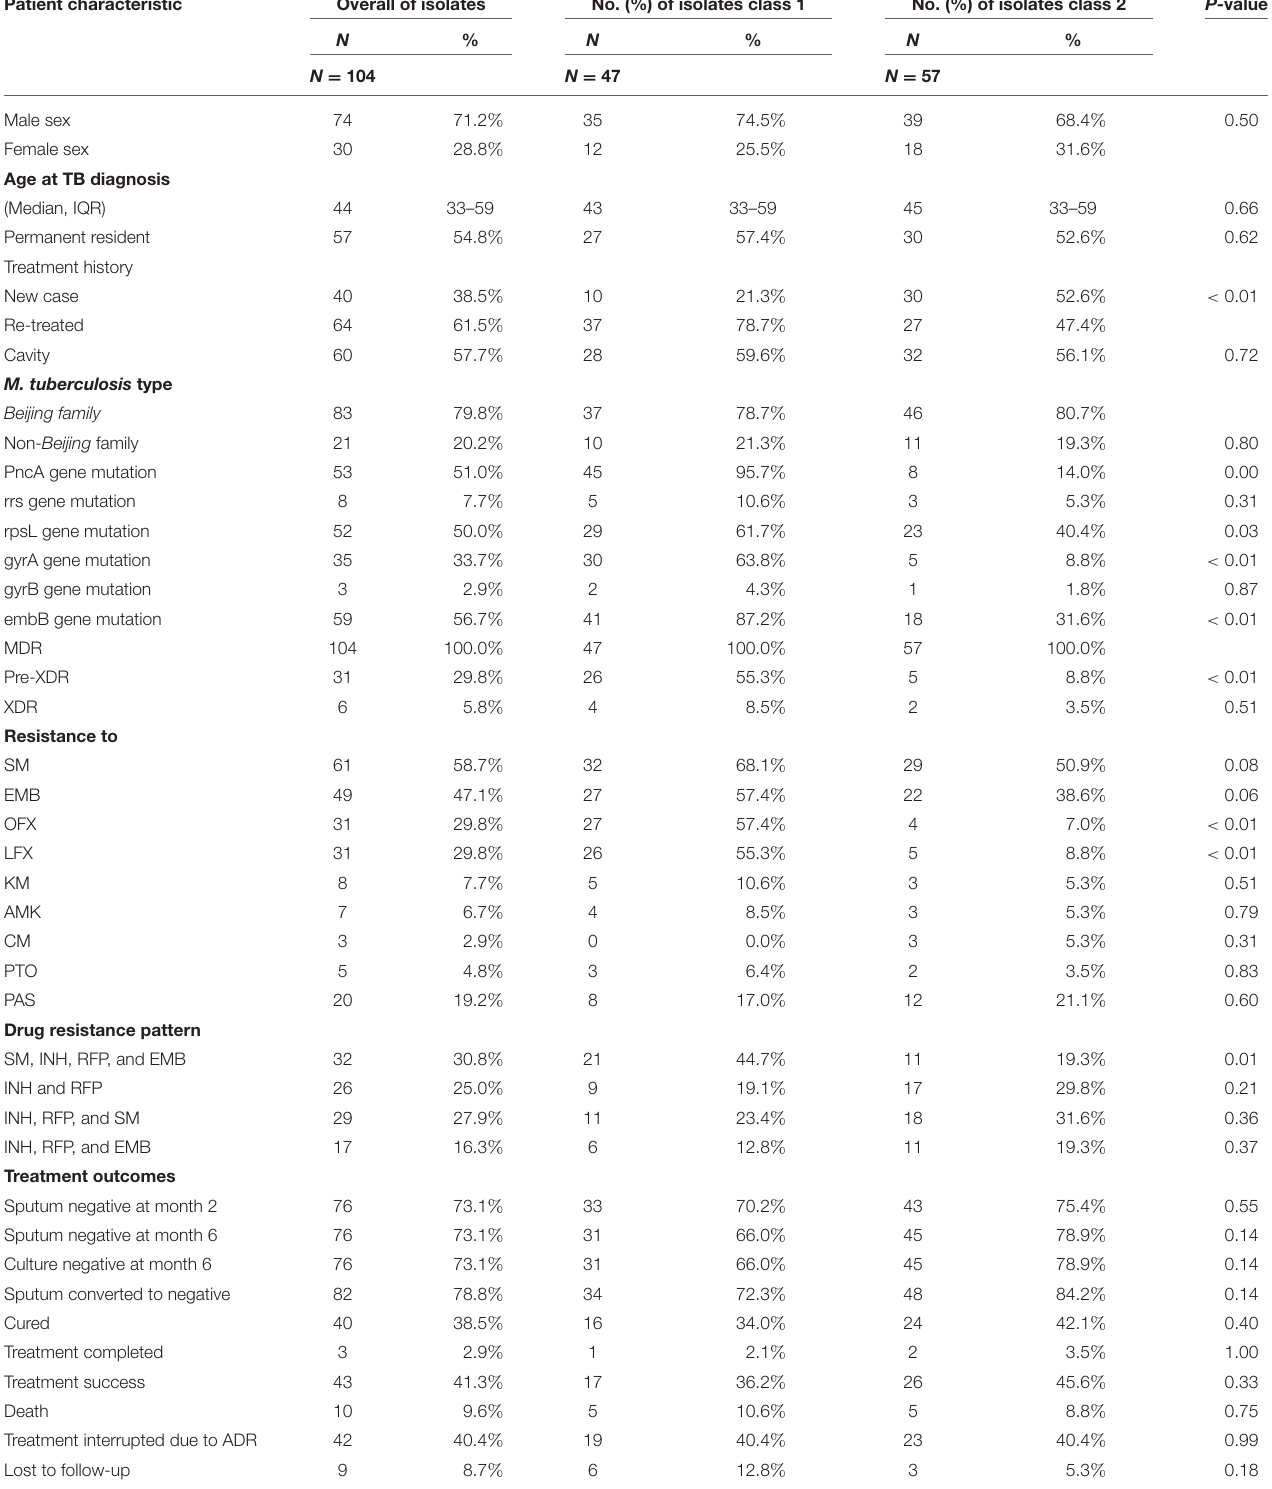
TABLE 1 | Baseline characteristics for the eligible patients with MDR-TB according to genetic determinants of drug resistance patterns. Patient